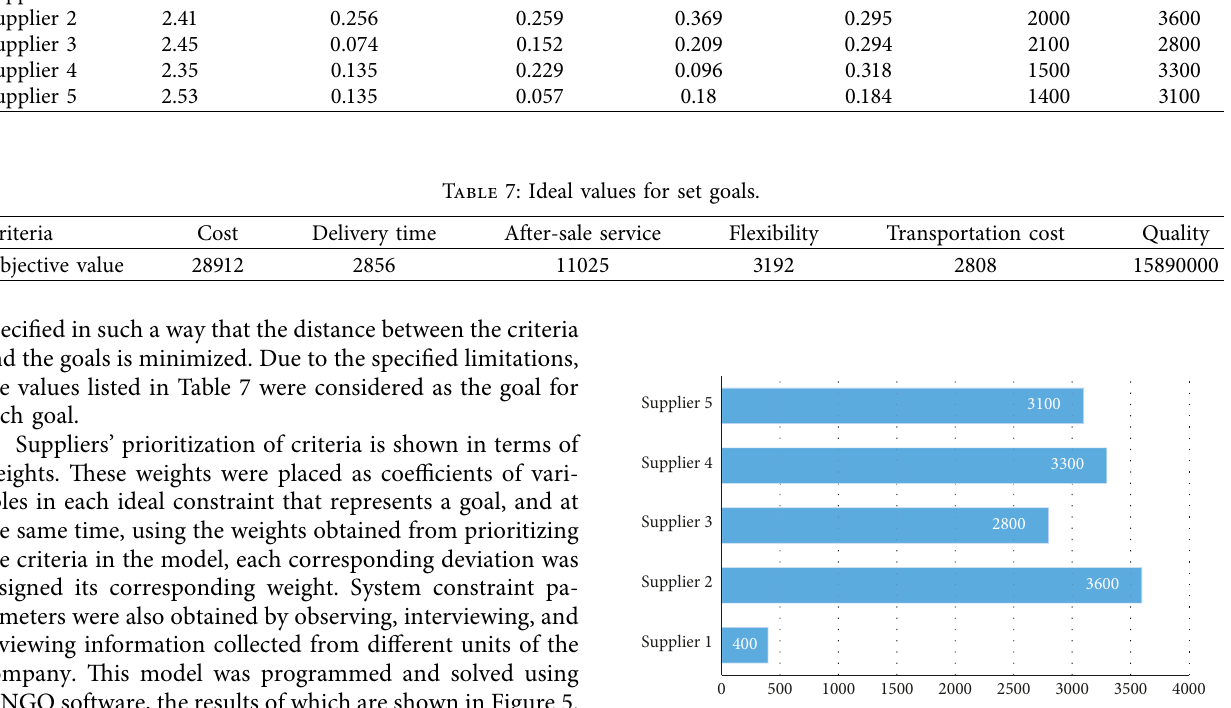
Figure 5: Optimal order allocation to